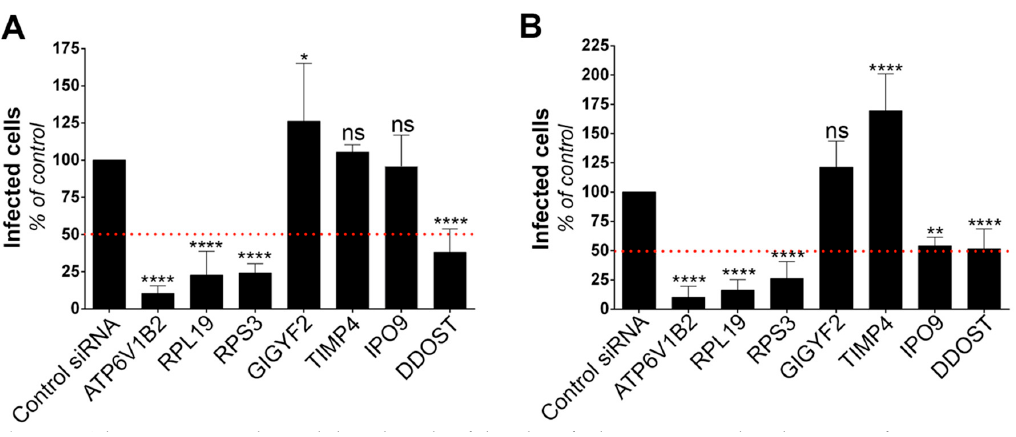
Figure 2. Silencing approaches validate the role of the identified genes on viral replication. Infection assays performed with YFV (A) and WNV (B) in HeLa cells 48 h following transfection with siRNA targeting candidate genes. The percentages of cells that expressed the viral E protein were determined by flow cytometry analysis 24 h post-infection. Data are normalized to non-targeting siRNA transfected cells. They are represented as mean ± SD of at least three independent experiments. Significance was calculated using one-way ANOVA tests of comparisons to control siRNA-transfected